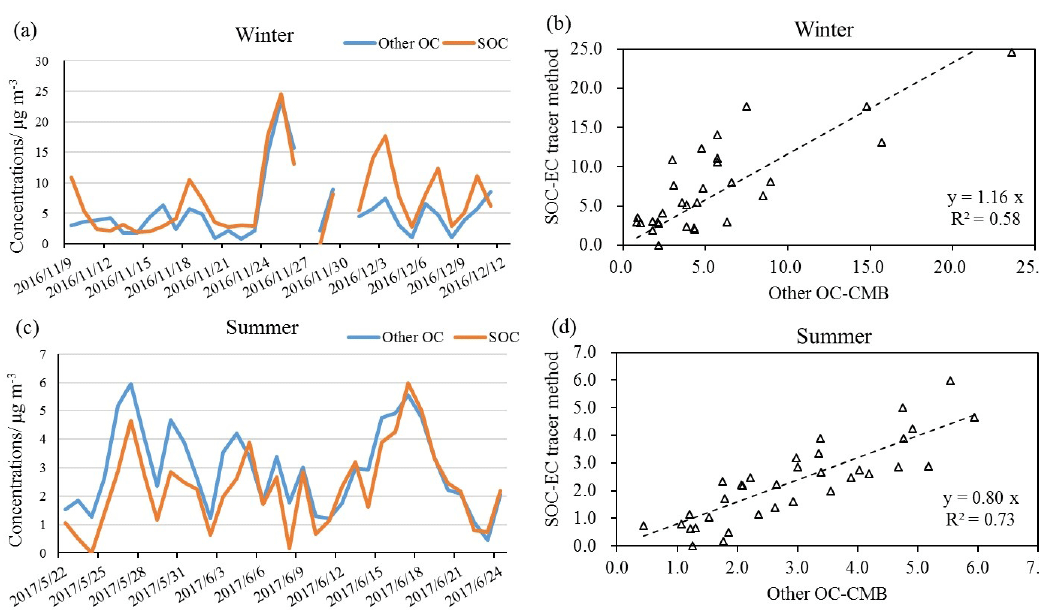
Figure 6. Time series of mean values for other OC estimated by the CMB model and SOC estimated by the EC-tracer method in winter (a) and summer (c) ; correlation relationship between other OC estimated by the CMB model and SOC estimated by the EC-tracer method in winter (b) and summer (d) .